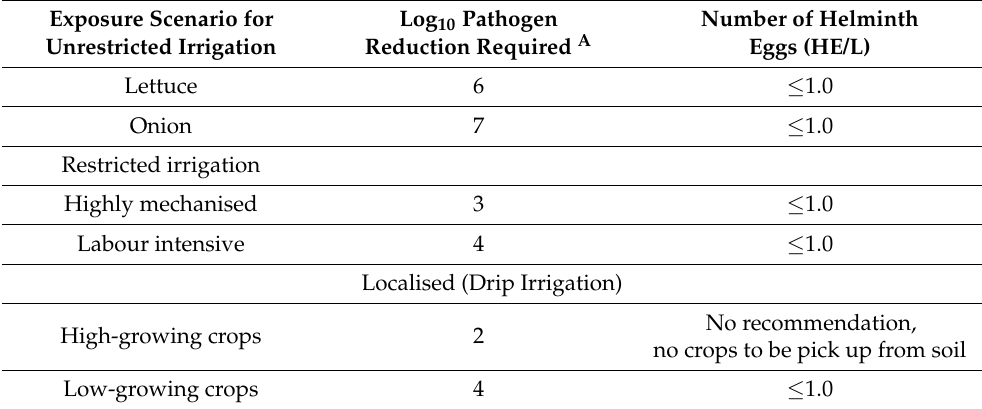
Table 2. Helminth-based targets for agriculture.